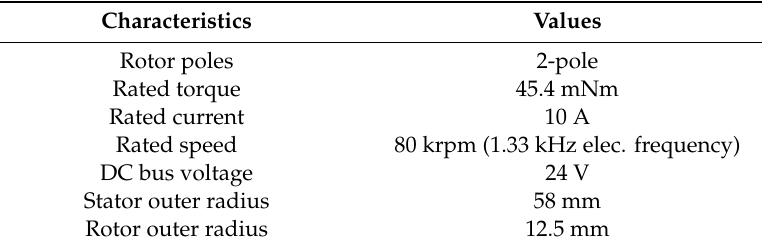
Table 1. Test PM machine characteristics.